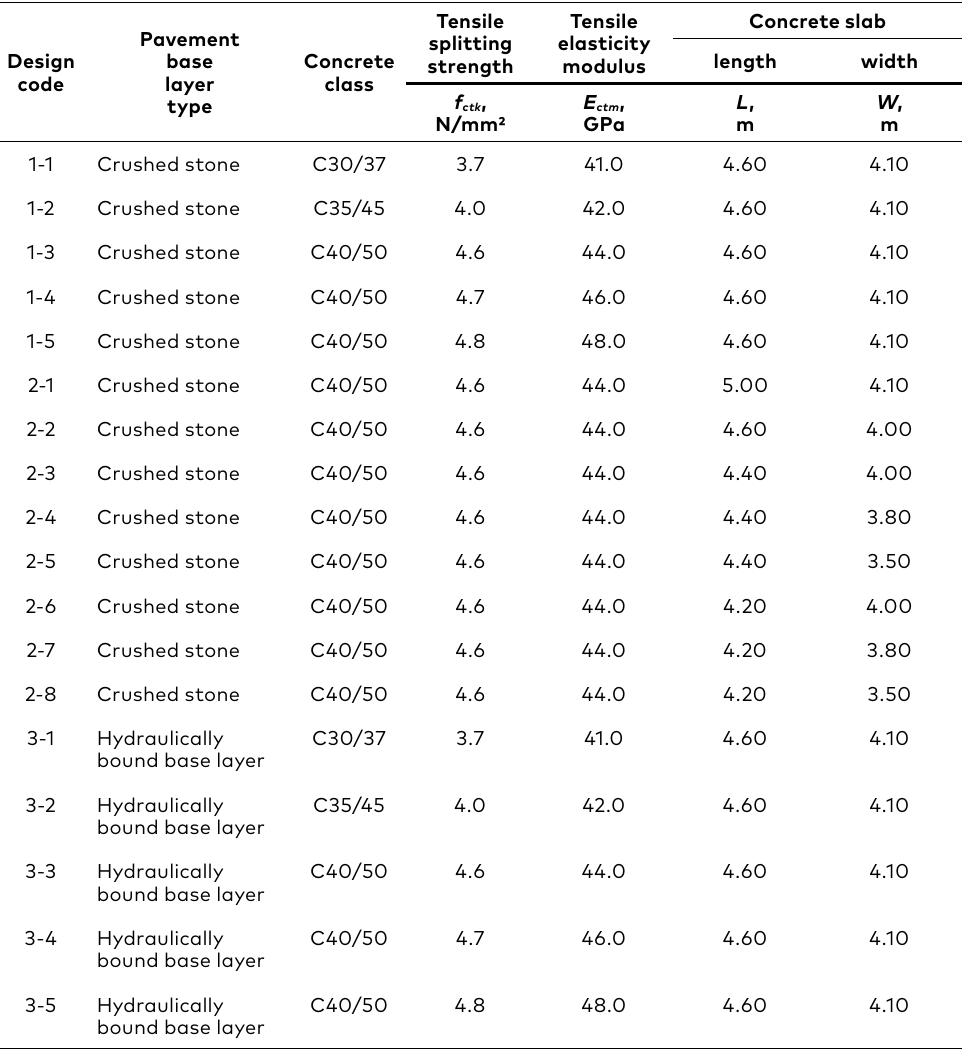
Table 8. Concrete pavement design